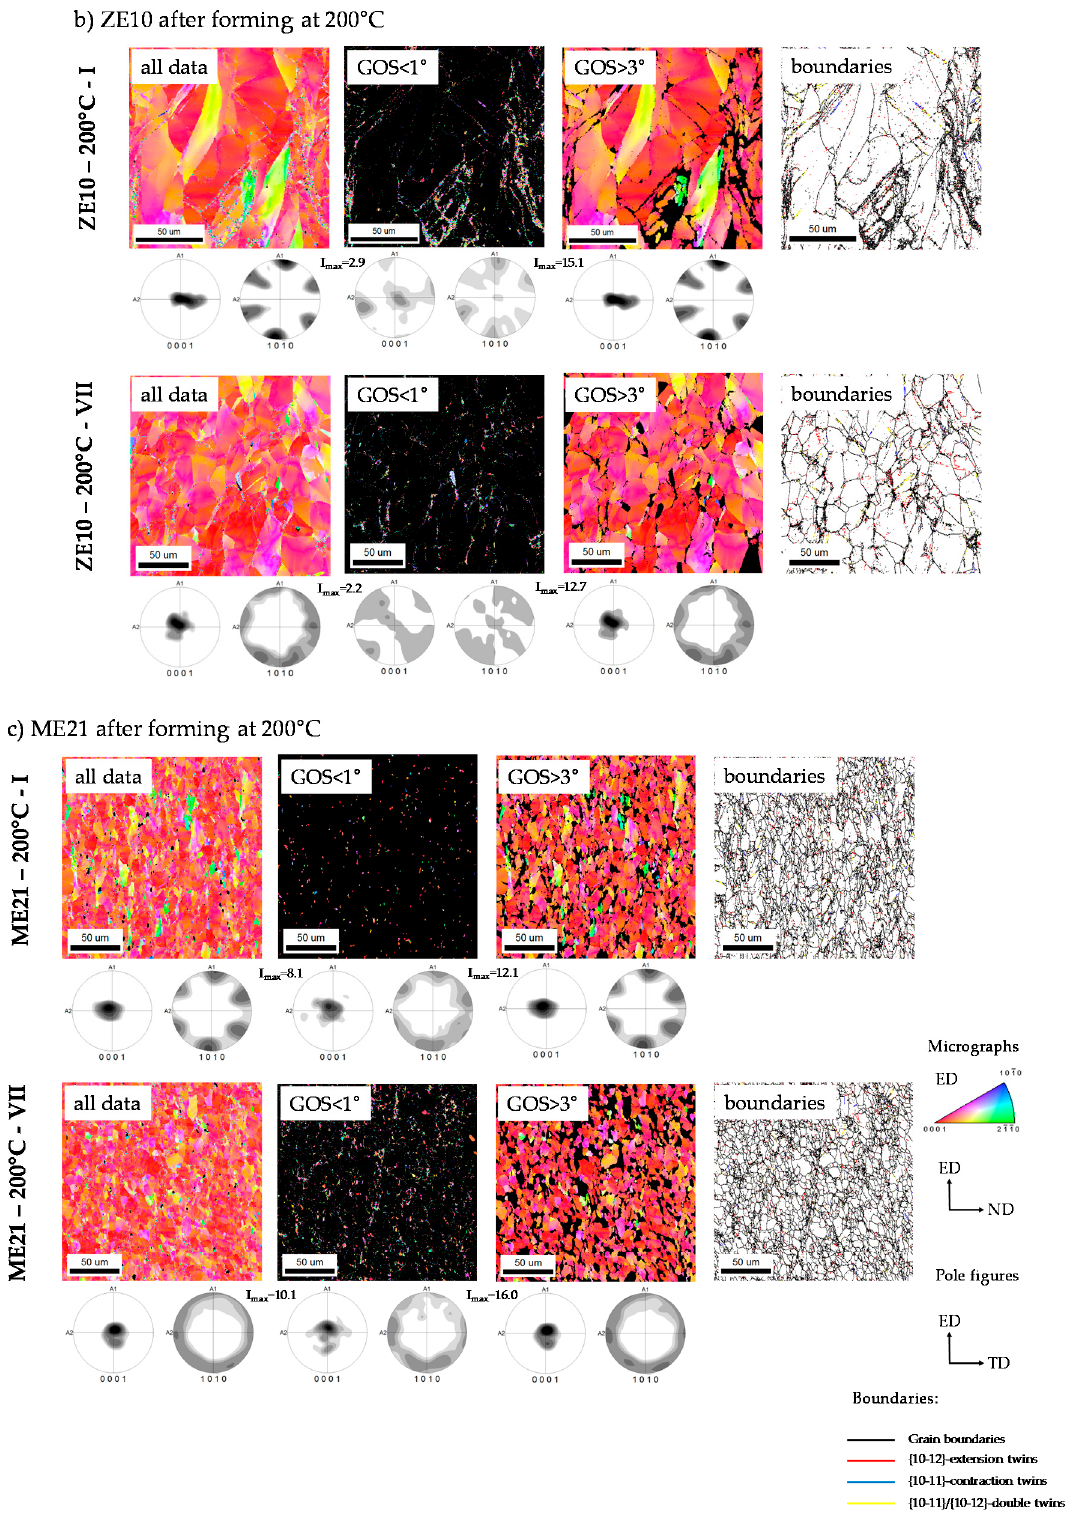
Figure 6. Electron backscatter diffraction (EBSD) orientation maps and pole figures of two selected sample geometries, I and VII, after the forming test of ( a ) AZ31, ( b ) ZE10, and ( c ) ME21; orientation map oriented parallel to ED.